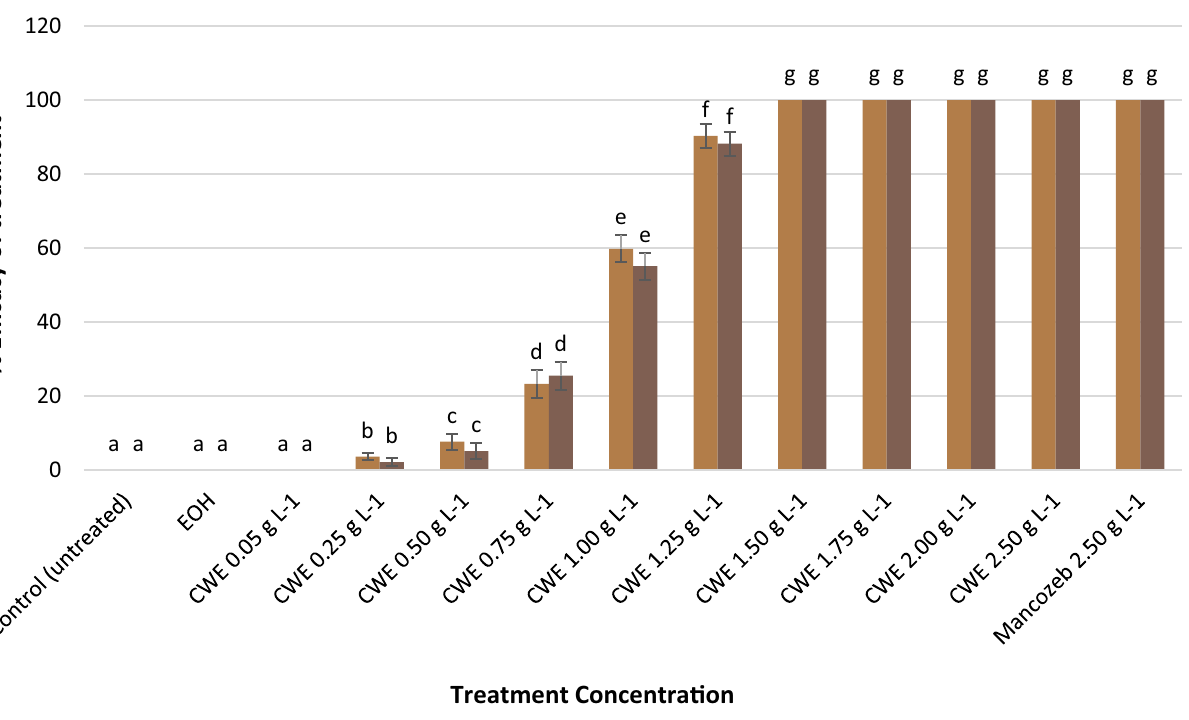
Figure 1. CWE’s effect on C. musae mycelial development seven days after treatment. Trials 1 and 2 are illustrated by the dark and light bars, respectively. Based on the Tukey test, values followed by similar letters are not statistically